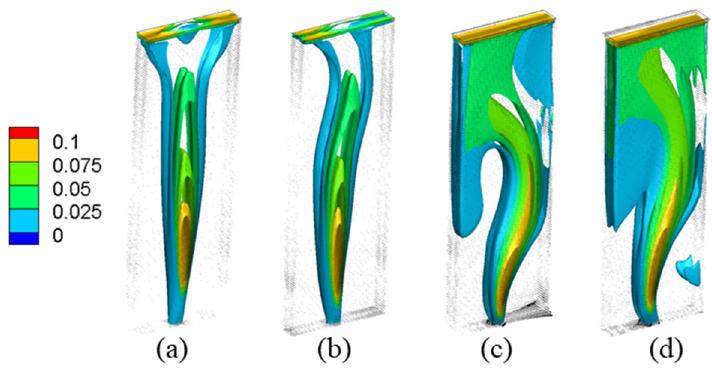
Figure 3. Instantaneous gas fraction from 0 to 0.1 and liquid velocity fields in the test case of ξ 3R3 at ( a ) 5 s, ( b ) 10 s, ( c ) 15 s, and ( d ) 20